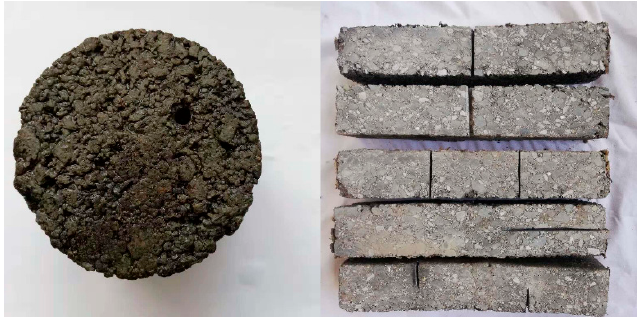
Figure 1. The factitious damage of specimens.